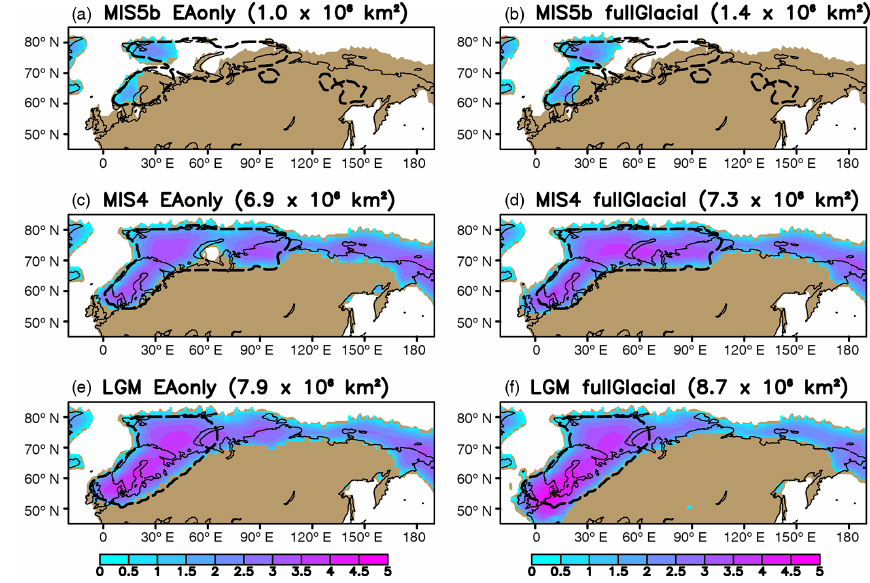
Figure 9. Same as Fig. 7 but using the climate forcing from the atmospheric simulations with BO2009